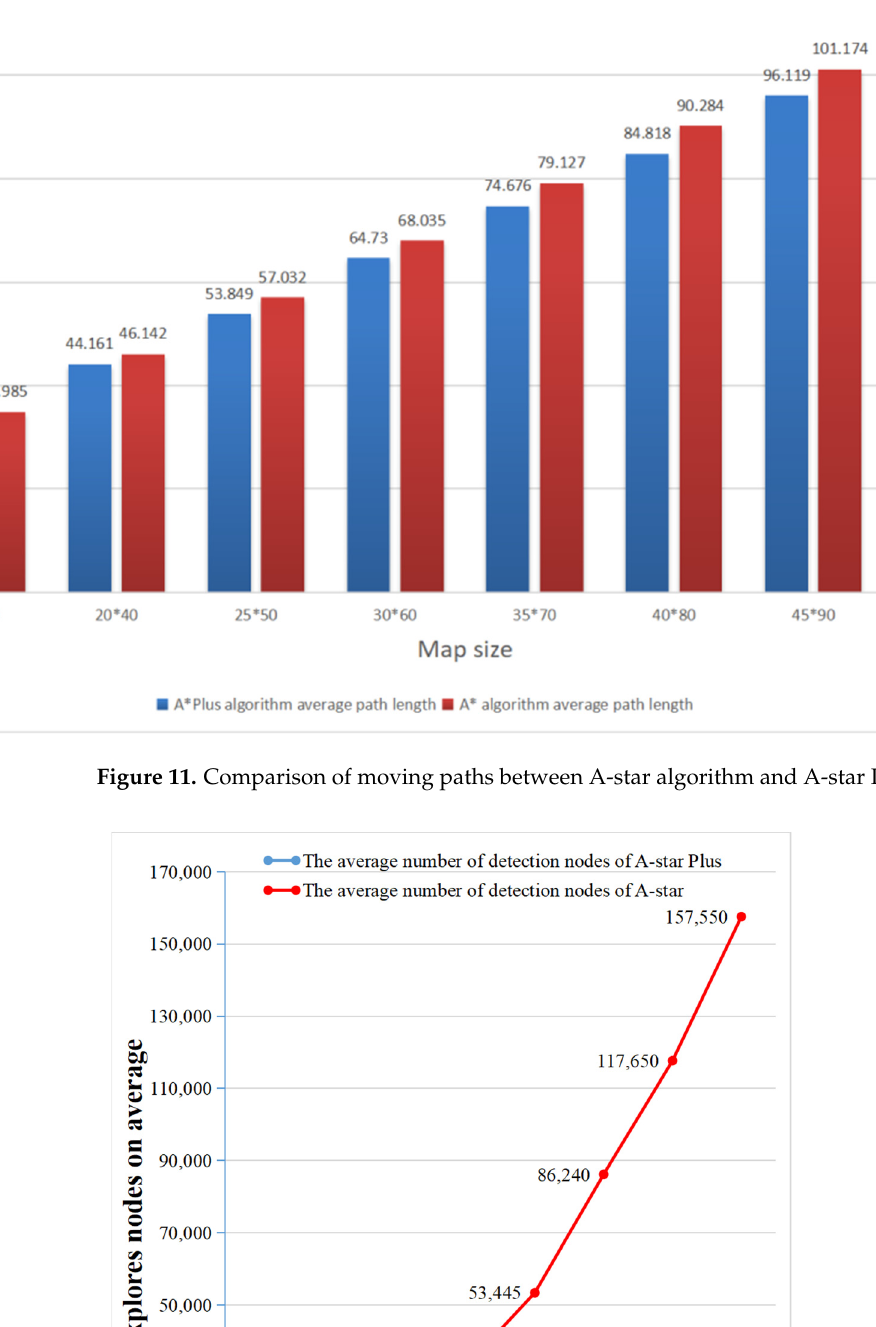
Figure 13. Comparison of calculation time between A-star algorithm and A-star Plus algorithm.